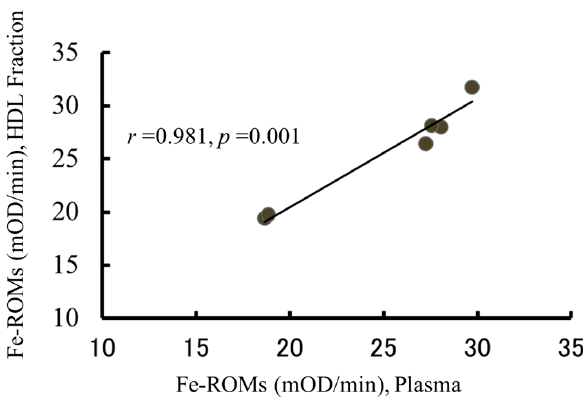
Figure 4. The correlation between the Fe-ROMs levels in the plasma and HDL fraction. HDL fractions were isolated from the plasma of six healthy subjects (aged 27–69 years), as described in Figure 3. The Fe-ROMs values were then measured by using these plasma samples and isolated HDL fractions. The correlation between the Fe-ROMs levels in the plasma and isolated HDL fractions is expressed by Pearson's correlation coefficient ( r = 0.981, p = 0.001).